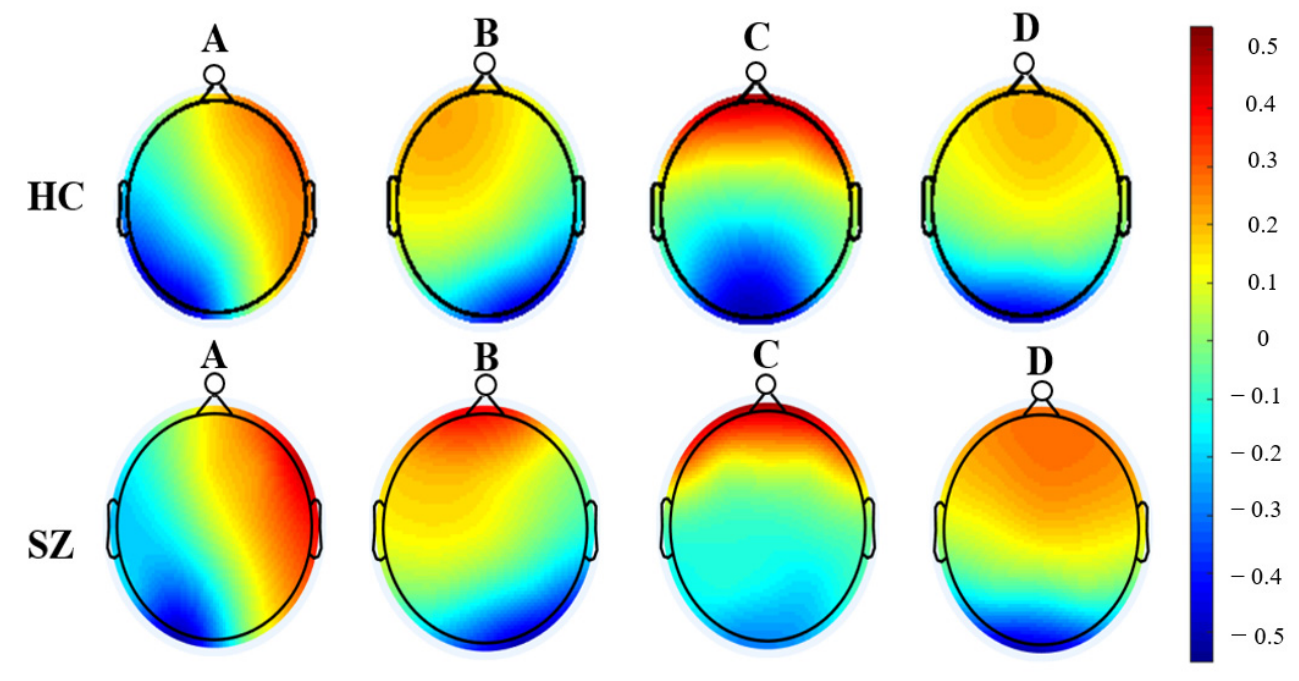
Figure 2. Four normalized microstates (i.e., A, B, C, and D) of resting-state EEG recordings were obtained for patients diagnosed with schizophrenia and healthy control subjects; SZ: patients diagnosed with schizophrenia; HC: healthy control subjects.